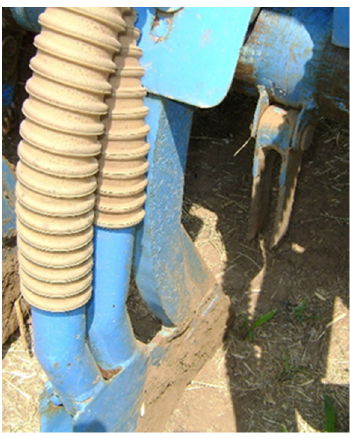
Figure 5. The Turbo Happy Seeder manages rice residue by flailing and lifting it on either side of the chisel ‐ tined no ‐ till slot opener.